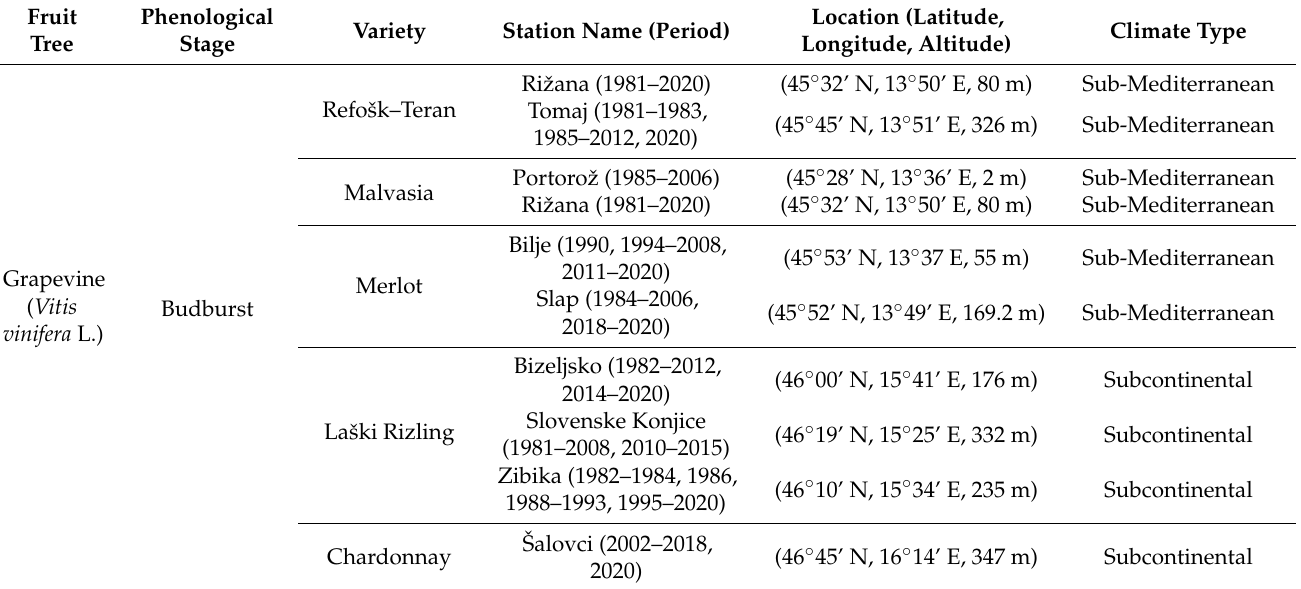
Figure 1. A topographic map of Slovenia (altitude in meters) and the locations of phenological stations where historical observations of the budburst day were available for our analysis. The stations are indicated by points for ( a ) grapevine, ( b ) apple, and ( c ) sweet cherry. Table 1. Summary of the phenological database used in the analysis—observations of budburst dates by location of phenological stations, period, and climate type classification of the